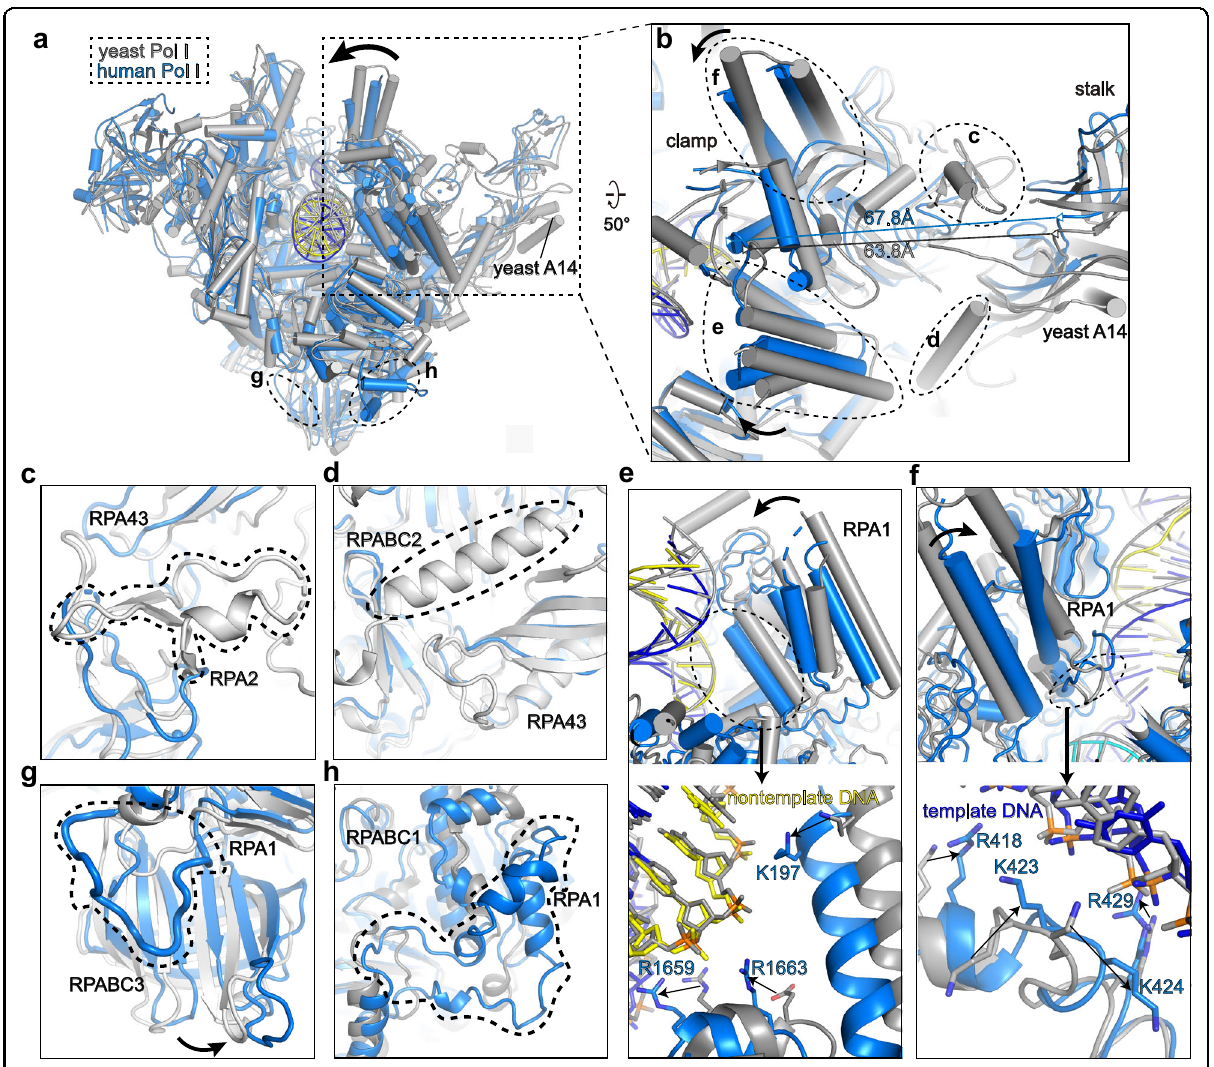
Fig. 2 Structural differences between hPol I and yPol I. a Structural comparison of hPol I (marine) and yPol I (gray) (PDB: 5M3F) 16 in the EC post state. b – f Close-up views of structural differences around the clamp between hPol I and yPol I and the differences are indicated with arrows. The hPol I subunits are labeled. Two dashed circles in c , d indicate the residues 1133 – 1168 of A135 and residues 52 – 68 of Rpb6 in yPol I, respectively. These two regions do not exist in hPol I. Two different views of the structural difference in the clamp are shown in the top panels of e and f and more details are shown at the bottom panels. Two dashed circles in g , h indicate residues 721 – 732 and 1078 – 1131 insertions of RPA1 that exist in hPol I but not in yPol I,